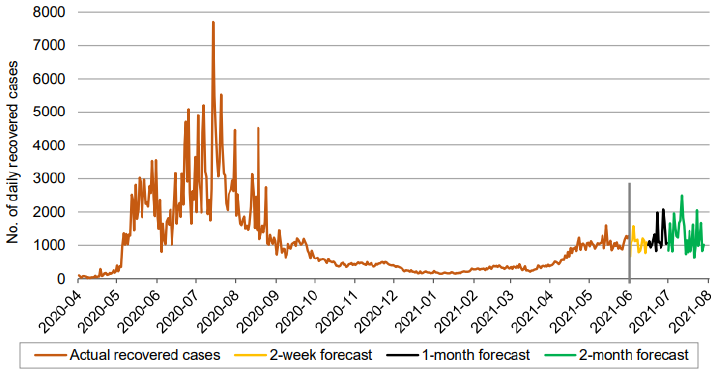
Figure 6. Prediction over a 60-day forecast for the recovered cases using the LSTM model.